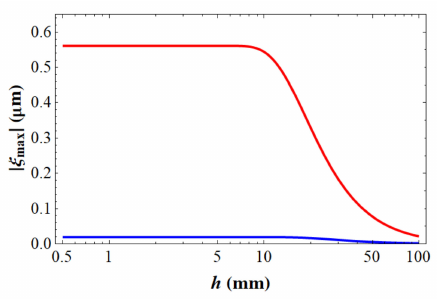
Figure 12. This plot shows | ξ max | in dependence of h , at a fixed exposure time t exp and R for float glass (red line) and Nextrema ® (blue line).